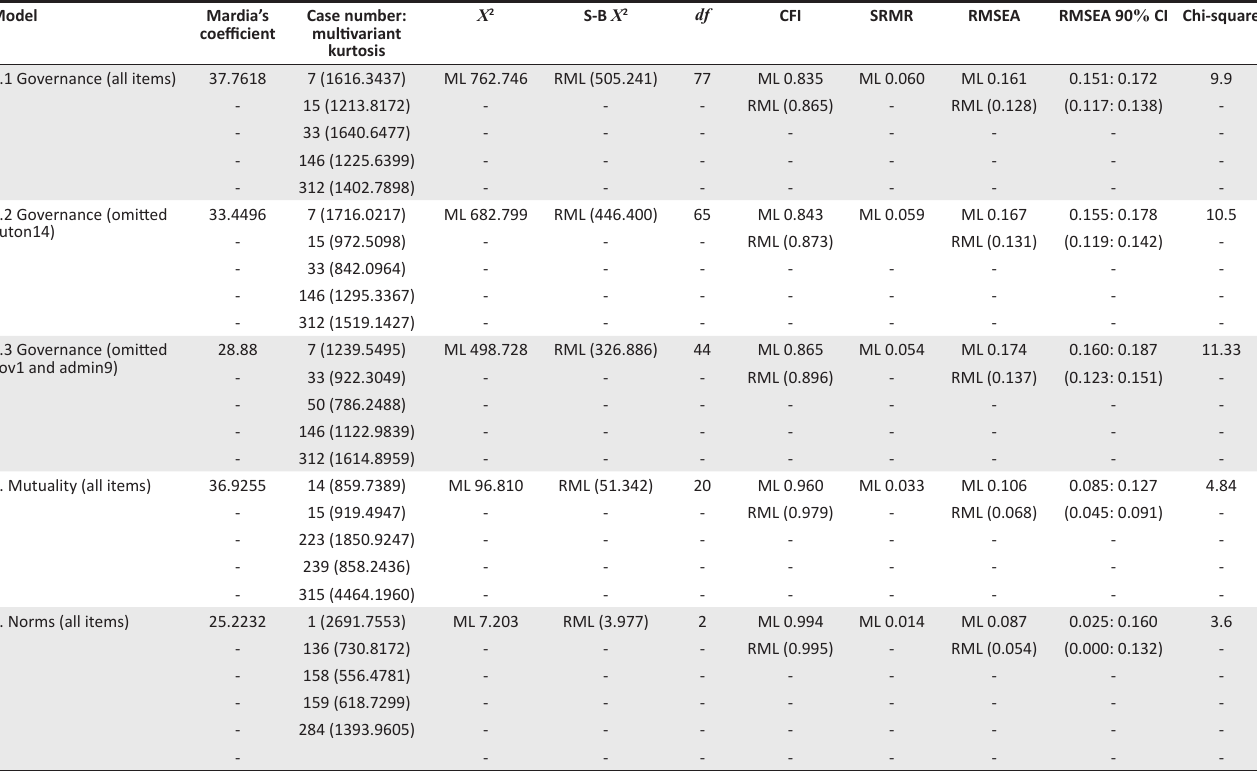
TABLE 3: Confirmatory Factor Analysis for the revised Thomson, Perry and Miller (2007) Collaboration Instrument and the Trust in Teams Scale.